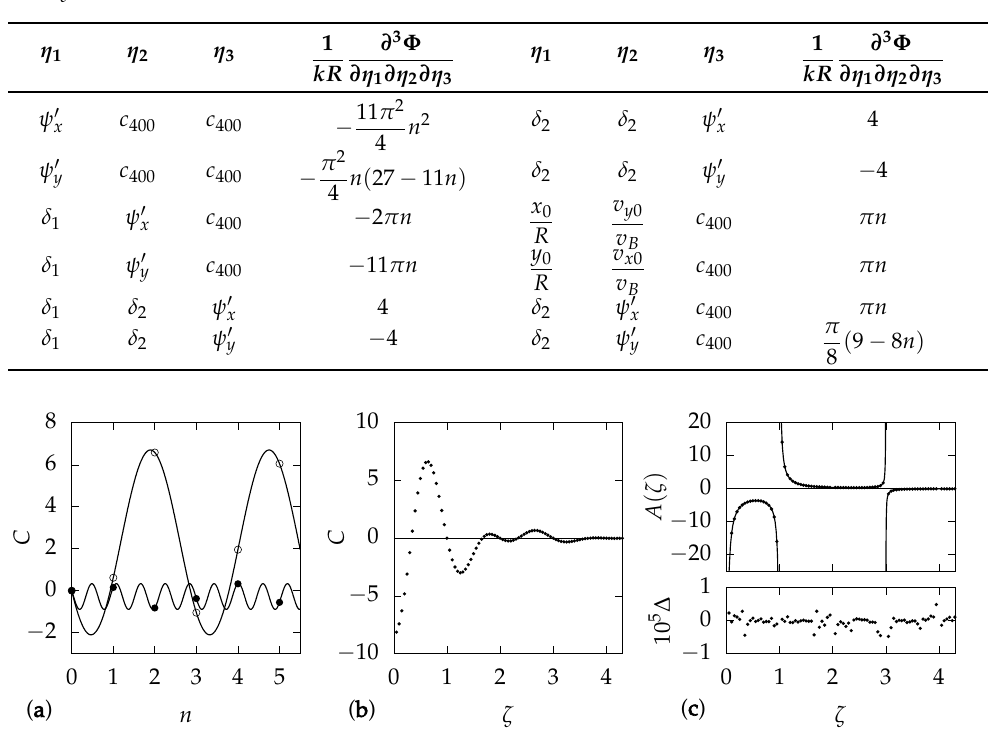
Figure 2. Analysis of numerical results, for the example term C = ( 1/ kR ) ∂ 2 Φ / ∂η 1 ∂η 2 with η 1 = ψ (cid:48)(cid:48) y and η 2 = c 301 . ( a ) Variation of C with orbit number n . The open points show results for ζ = 0.35, and the filled points for ζ = 1.7. From the analytical results, we anticipate that the phase will vary sinusoidally with 2 πζ n , and we also know that Φ = 0 at n = 0. We therefore fit the points to